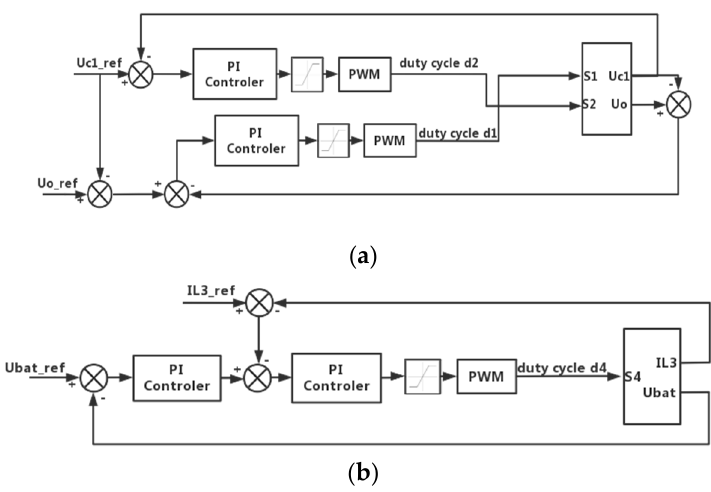
Figure 4. System control block diagram: ( a ) control block diagram of state 1 to 4 ( d 1 = d 2 at state 1 and 2, d 1 ≠ d 2 at state 3 and 4); ( b ) control block diagram of state 5.